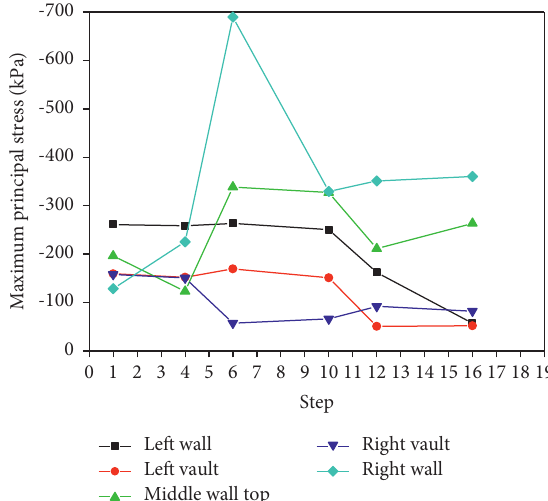
Figure 9: Maximum principal stress of scheme III. Figure 10: Minimum principal stress of scheme